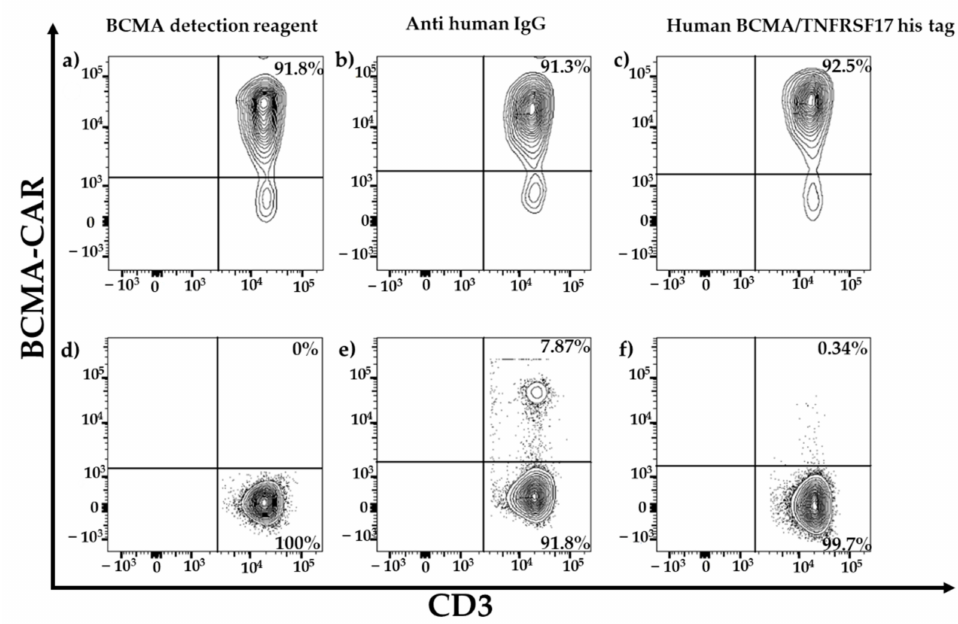
Figure 2. Comparison of different staining reagents for BCMA-CAR-T cells. Panels ( a – c ) show the transduction efficiency of BCMA-CAR-T cells manufactured from one healthy donor for the three reagents for staining BCMA-CAR-T cells in flow-cytometry contour plots. Panels ( d – f ) show the comparison of the specificity (background staining) of the three different reagents in flow-cytometry contour plots with outliners performed on fresh PBMCs from one healthy donor.